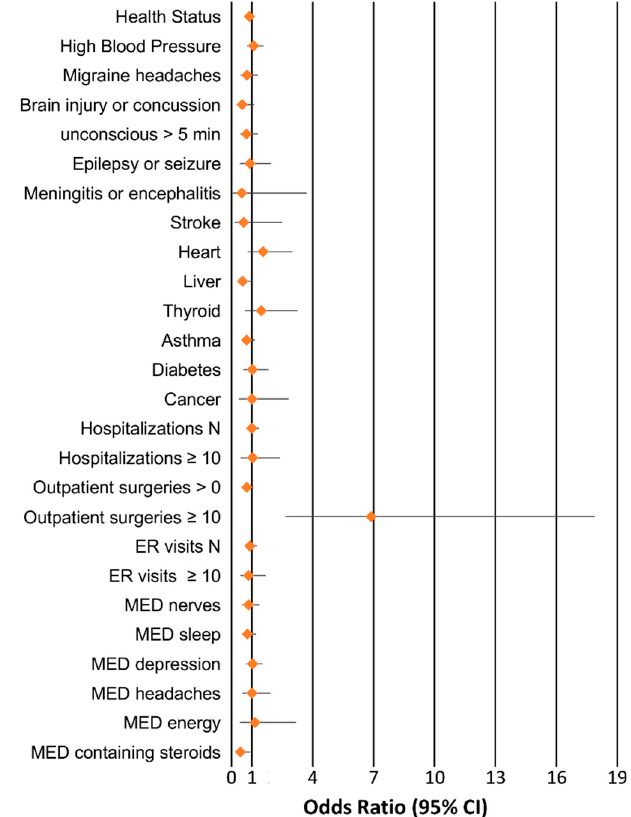
Figure 1. Associations between Transthyretin ( TTR ) V122Ile and traits related to medical history. Odds ratio and 95% confidence intervals are reported for each association.